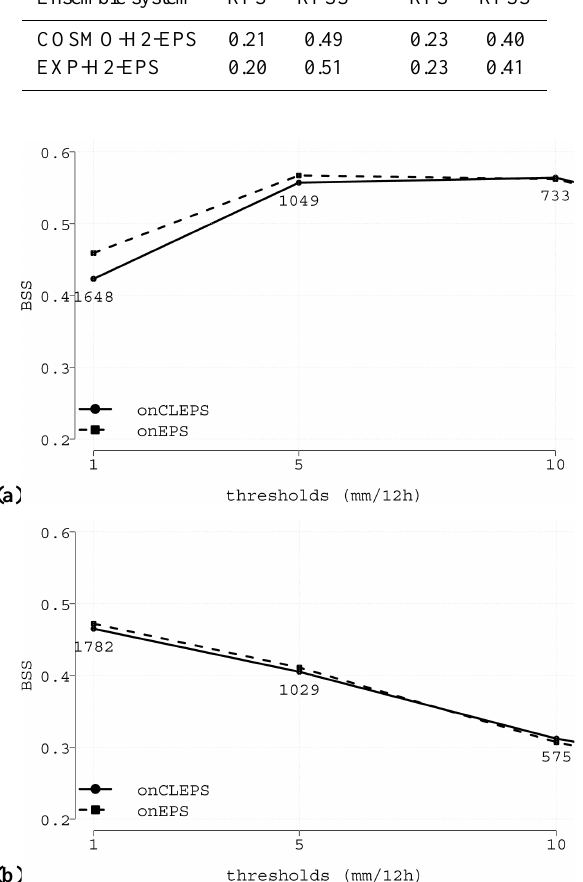
Fig. 7. Brier skill score of COSMO-H2-EPS (solid line, labelled “onCLEPS”) and EXP-H2-EPS (dashed line, labelled “onEPS”) as a function of the threshold for the 6–18h (a) and 18–30h (b) fore- cast range. Verification is performed for 12-hourly precipitation. Numbers indicate the observed occurrences of each event.